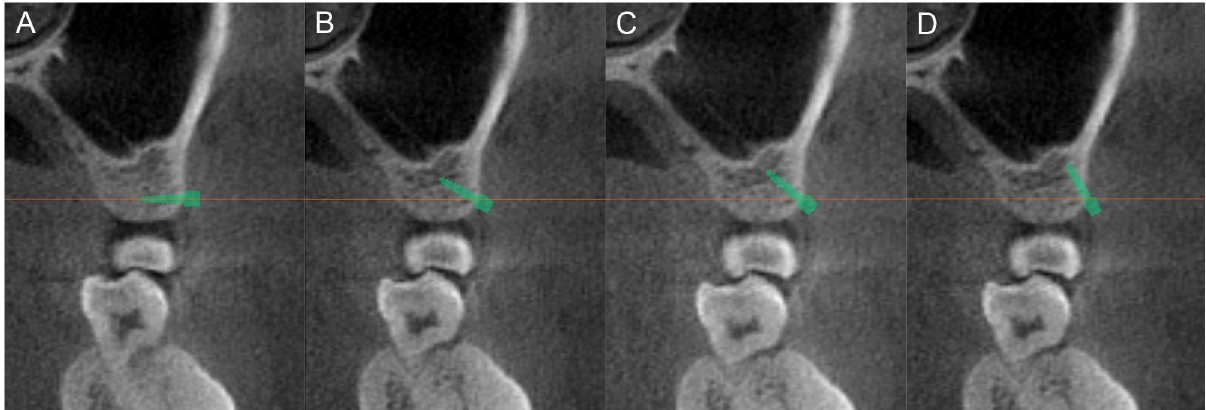
Fig 4. Miniscrew insertion angles. The miniscrews are placed at four different vertical angles relative to the horizontal axis of the software, which is parallel to the transverse occlusal plane. (A) 0˚; (B) 30˚; (C) 45˚; (D)